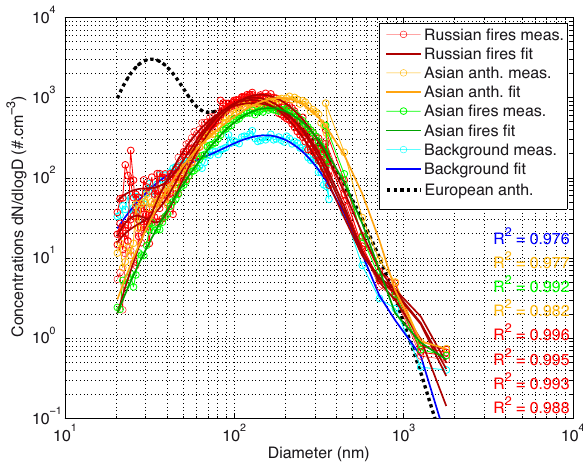
Fig. 11. Measured (thin solid line with circles) and fitted (thick solid line) aerosol number size distributions corresponding to Russian and Asian plumes transported to the Arctic. Distributions are fitted with three mode, corresponding correlation factors are indicated. Red and green distributions represent Russian and Asian forest fires, respectively; yellow distributions represent the Asian anthropogenic plume. For comparison reason, a polar background distribution is shown in blue and in addition, a distribution related to the European anthropogenic plume sampled on 9 April (discussed in the first case